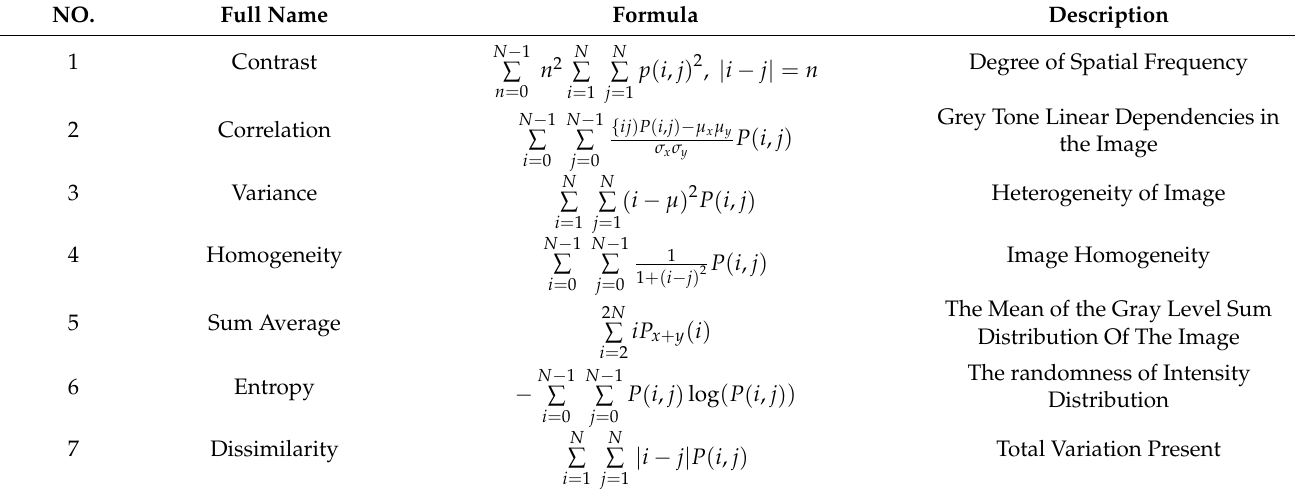
Table 4. Various types of spatial indices originated from the GLCM matrix